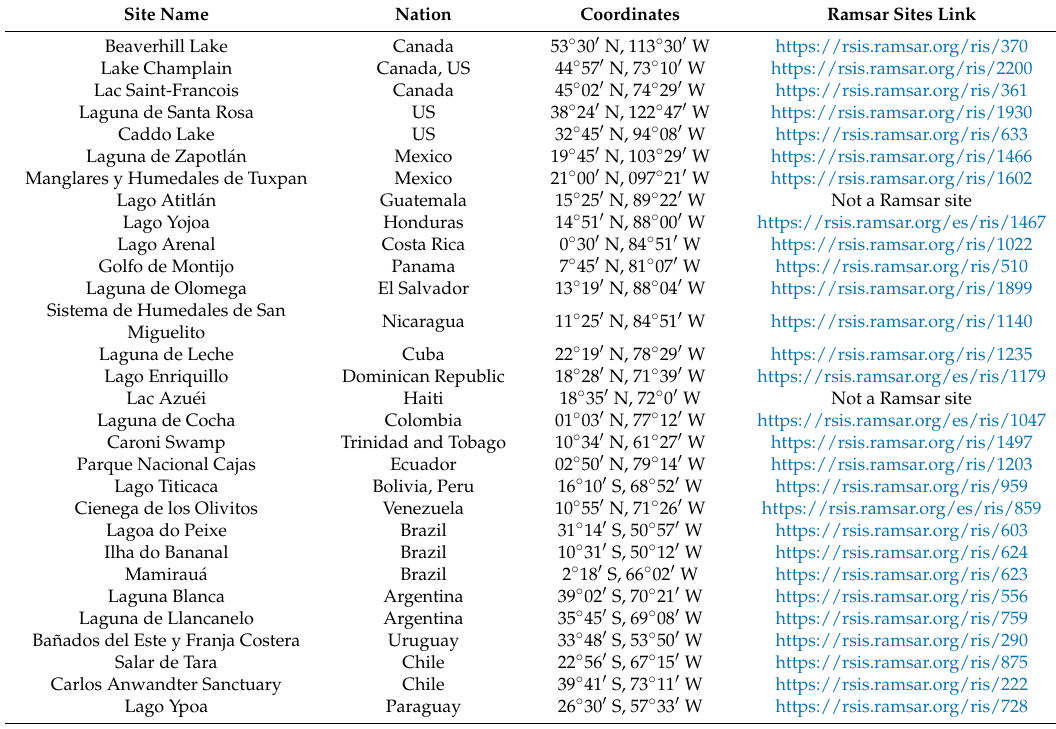
Table A1. Ramsar convention sites employed (three for larger nations, two for medium-sized nations, and one for all other